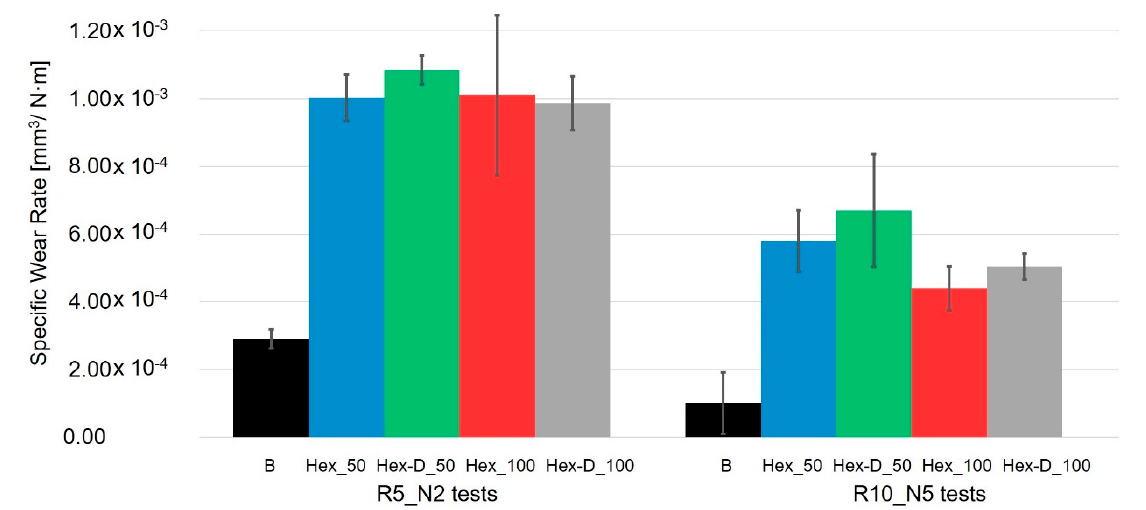
Figure 10. Specific wear rate from tribological tests after 20,000 laps.